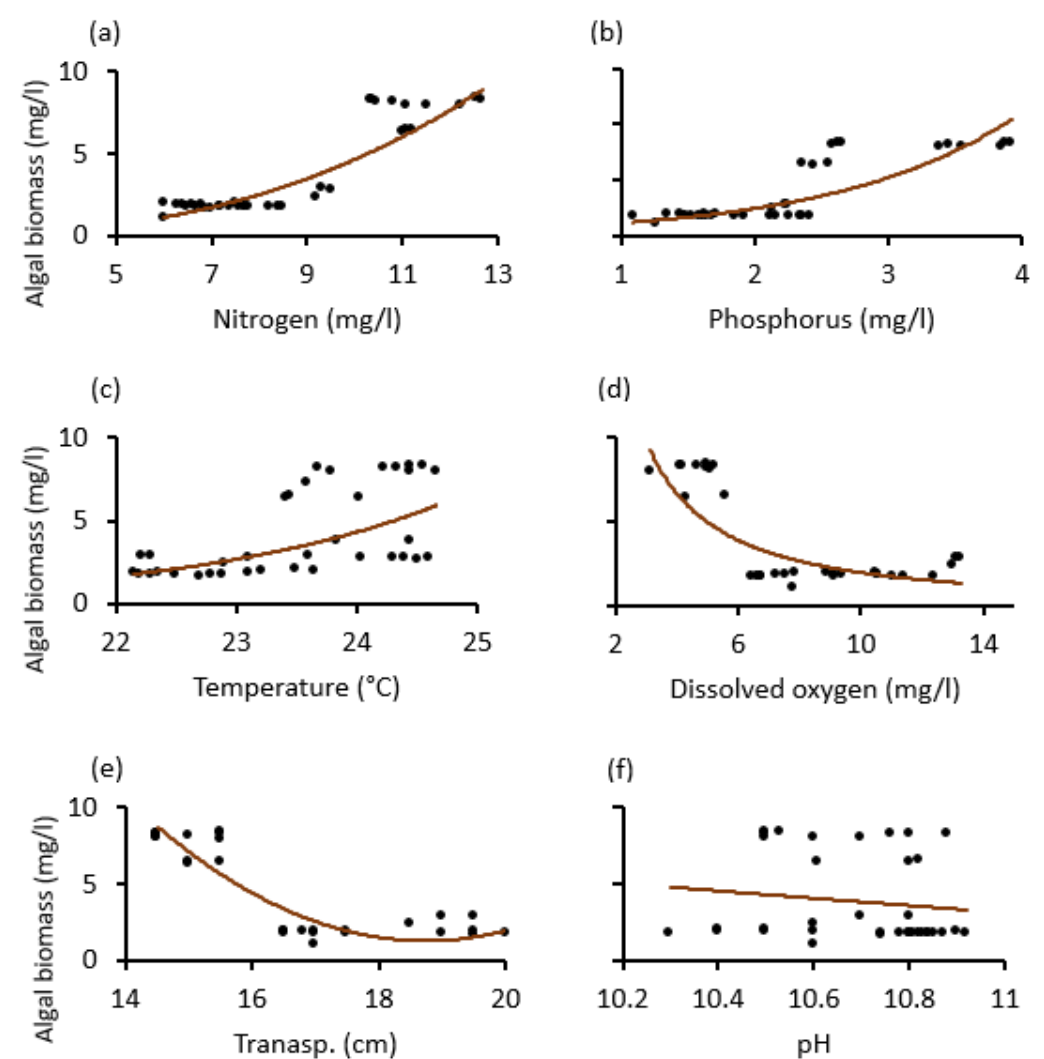
Figure 7. Relationship changes between algal biomass and the physico–chemical variables; ( a ) Nitrogen, ( b ) Phosphorus, ( c ) Temperature, ( d ) dissolved oxygen, ( e ) Transp. (water transparency) and ( f ) pH during the study period from May 2020 to April 2021 at Lake Rishateni, Tanzania.